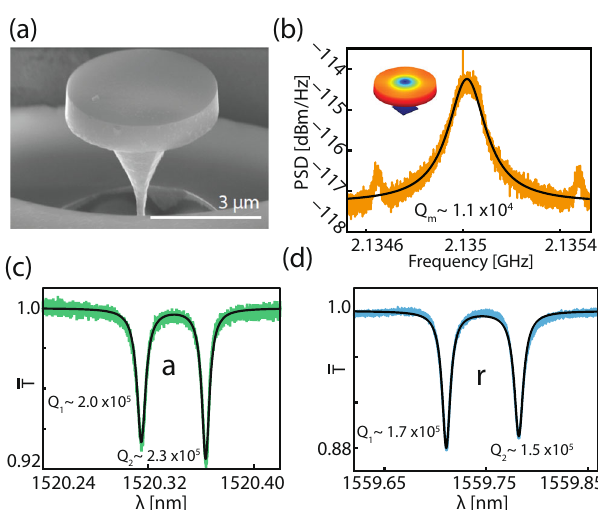
Fig. 7 Characterization of optical and mechanical modes. a Scanning electron micrograph of the diamond microdisk used in this work. b Measured power spectral density of radial breathing mode at room temperature and pressure (inset: COMSOL simulated displacement pro fi le). c , d Fiber taper transmission scans for both optical modes used in this work, revealing the doublet nature of the modes. Intrinsic optical quality factors are Data availability The datasets generated during and/or analyzed during this study are available from the corresponding author on reasonable request.